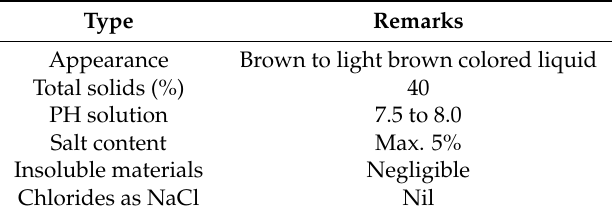
Table 2. Palm oil fuel ash characteristics [25].